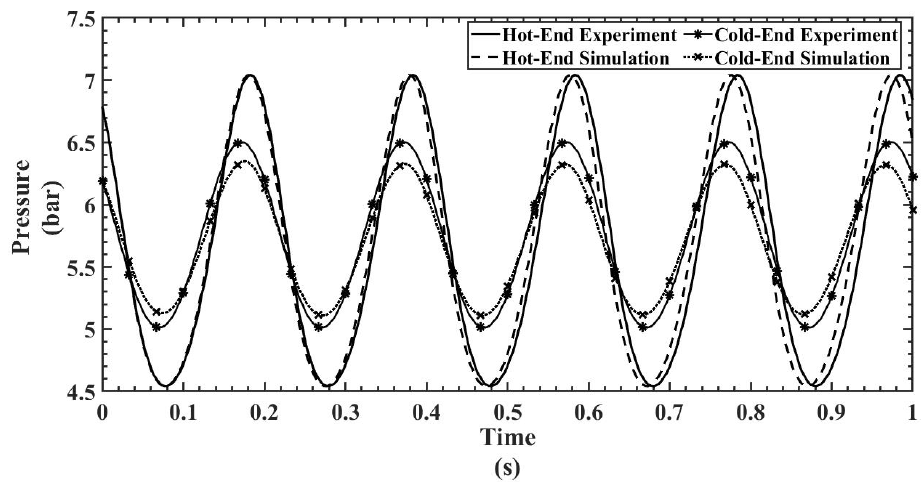
Figure 10. Hot- and cold-section pressure characteristics of a 300 mesh regenerator at 300 RPM.